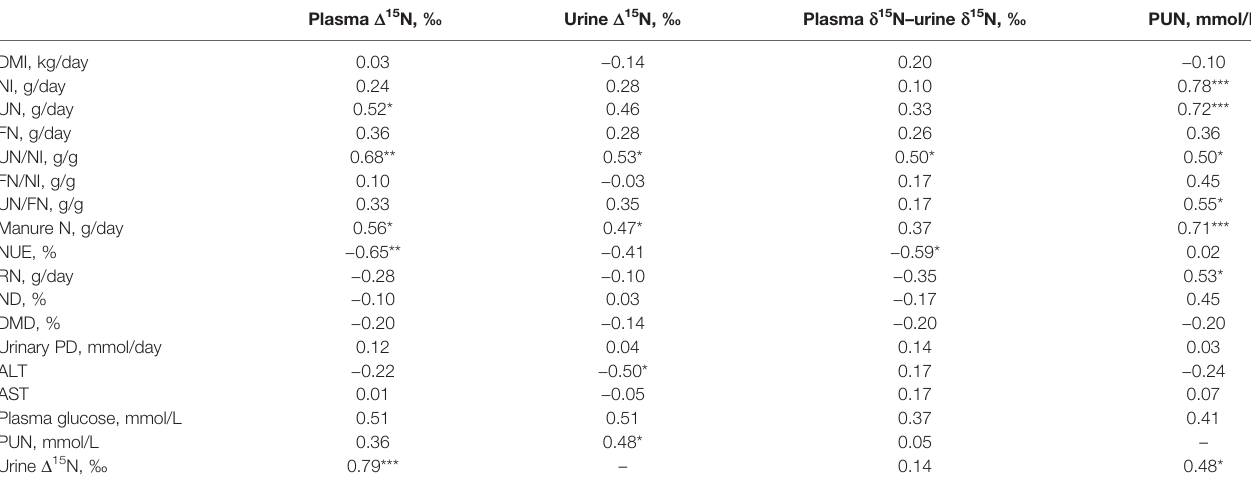
TABLE 4 | Pearson ’ s correlation coef fi cients (r) between plasma nitrogen (N) isotopic discrimination (plasma D 15 N), urine D 15 N, and plasma urea N (PUN) with N partitioning variables in